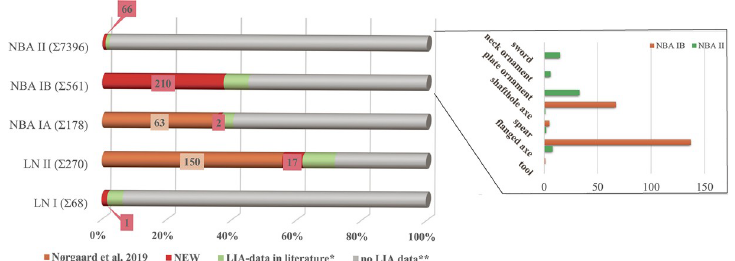
Fig 1. Analysed objects using lead isotope analysis (LIA) per period from the Neolithic to the established Bronze Age in southern Scandinavia. The number of analyses presented in this study is related to the published analyses [1,3,4,6–8,14,50,51]and given in percentages of the overall number of artefacts assumed for each period based on [17,48].For NBA IB and NBA II, the chief focus of this article, the distribution of the artefact categories analysed within the present study is shown in the separate